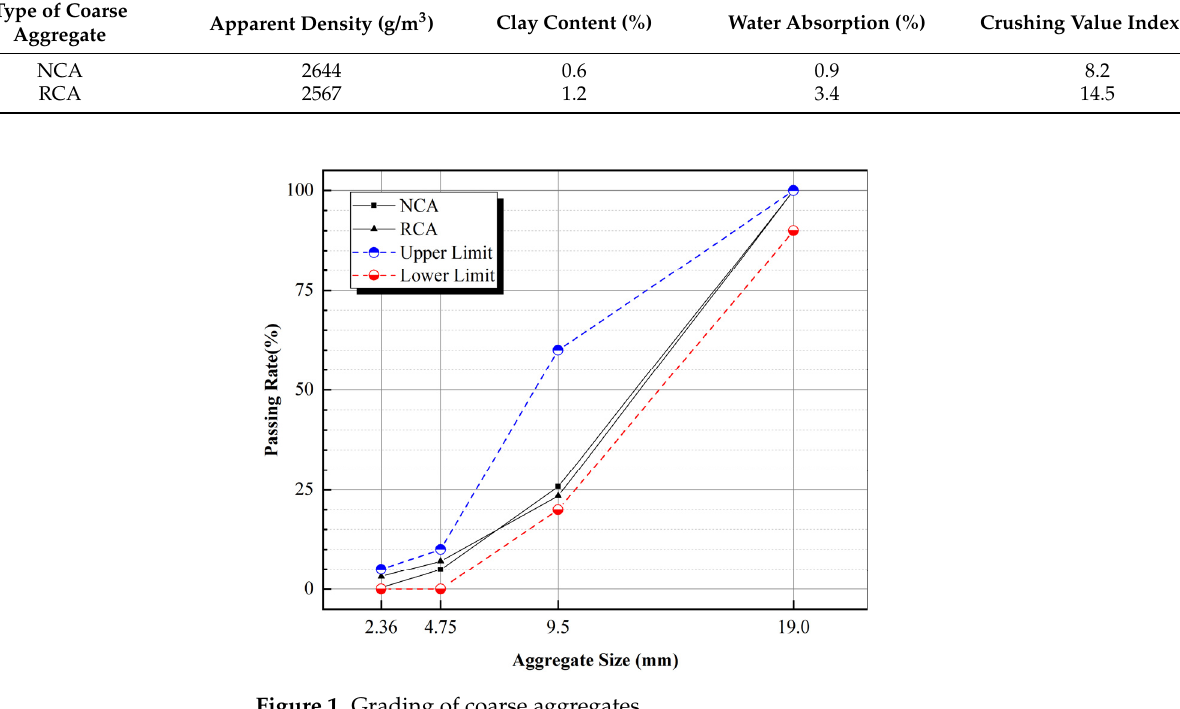
Figure 1. Grading of coarse aggregates. Table 2. Physical properties of coarse aggregate.